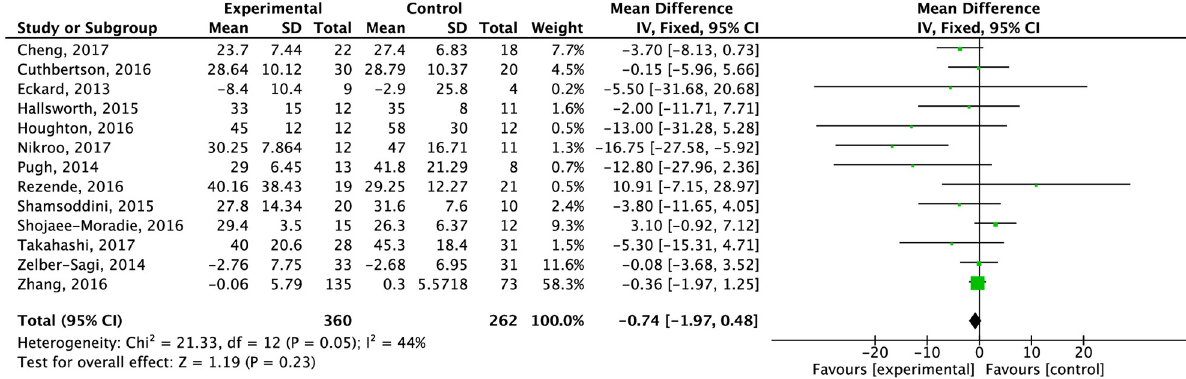
Fig 9. Effect of exercise compared to the control group in AST concentration.